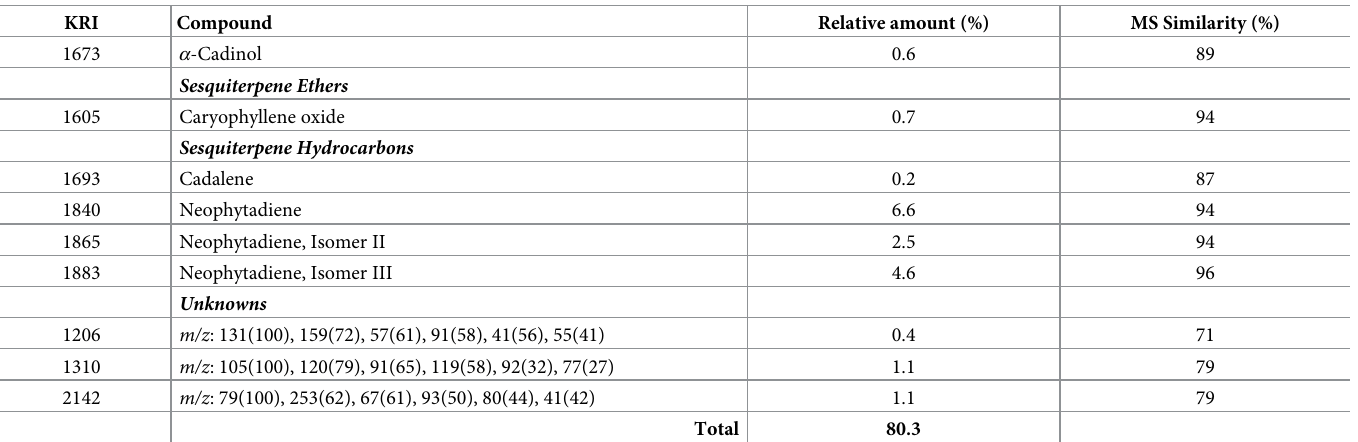
PLOS ONE | https://doi.org/10.1371/journal.pone.0214594 March 28,